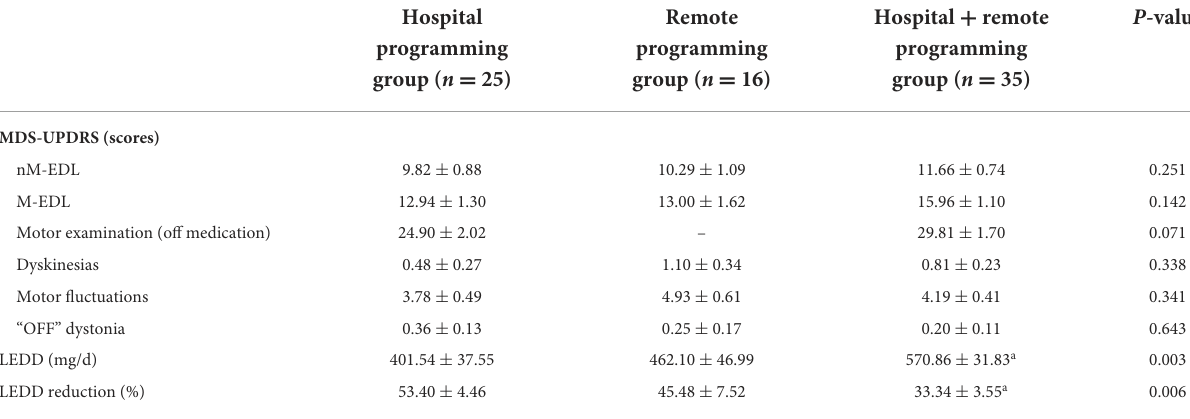
TABLE 2 A comparison of the postoperative clinical characteristics among the three groups undergoing bilateral